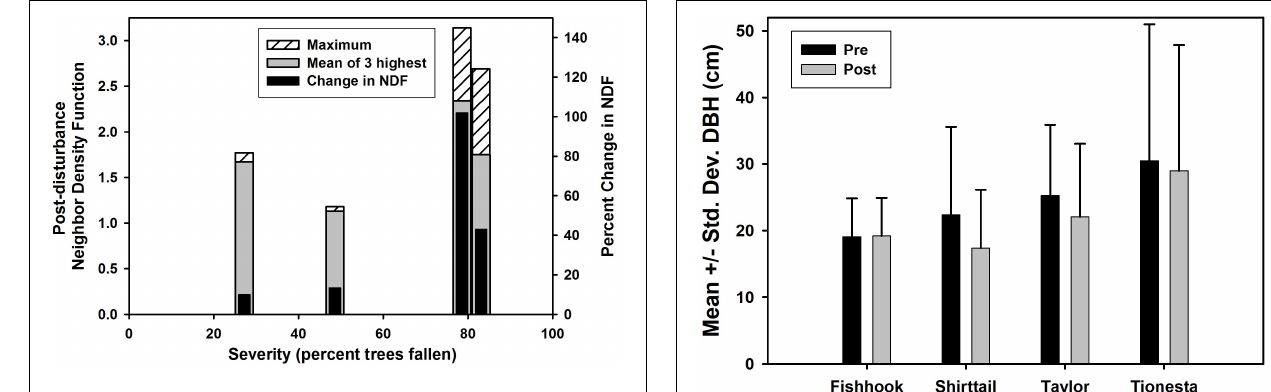
FIGURE 7 | Severity of wind damage (proportion of trees fallen) vs. three measures of the greatest spatial aggregation of post-disturbance trees at the four sites. From left to right, the vertical bars represent Tionesta, Fishhook, Shirttail, and Taylor; severities were 27.2, 48.6, 80.6, and 81.1%, respectively. Shirttail and Taylor offset slightly to left and right, respectively, to avoid overlap of the bars on the x axis. ‘Maximum’ represents the highest NDF value among post-disturbance survivors at any scale at the given site; ‘mean of 3 highest’ represents the mean of the three highest NDF values among post-disturbance survivors at the given site; ‘change in NDF’ represents the proportional increase in NDF between pre-disturbance trees and post-disturbance standing trees at the given site.